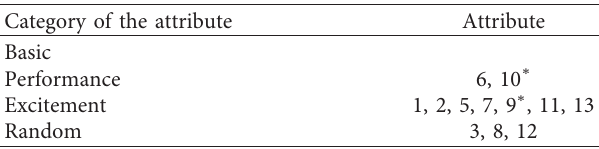
Table 12: Categories of the attributes based on the rules presented in Section 3 for the customer having high customer satisfaction (5).